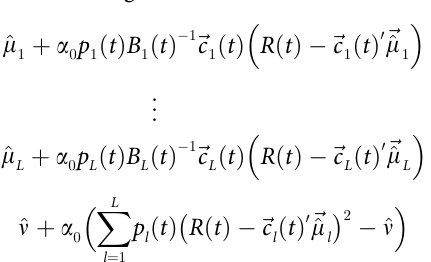
S2 Fig. Gershman (2017) model with higher concentration parameter. Simulated behavior of Gershman (2017) model with concentration parameter α = 1 for the same learning experi- ments in the main text. Gray dashes demarcate experimental